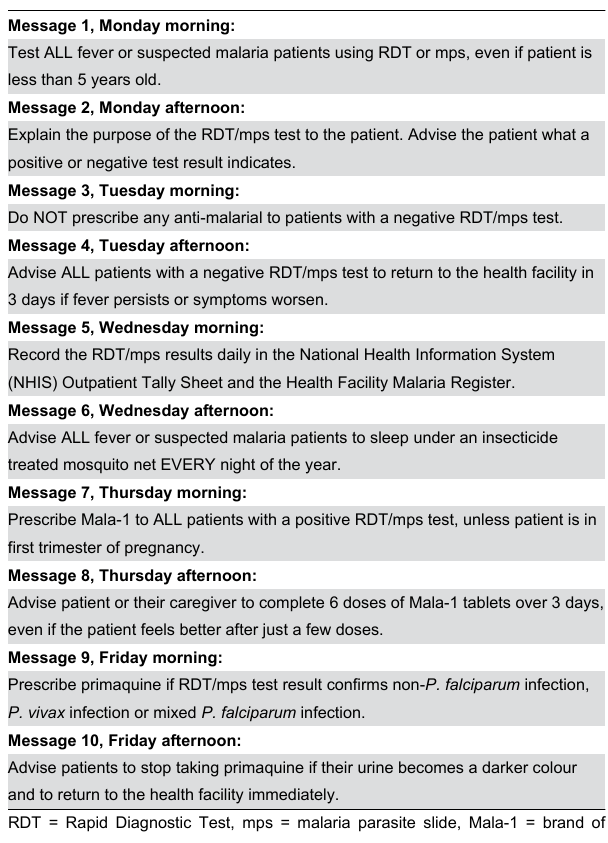
Message 1, Monday morning: Test ALL fever or suspected malaria patients using RDT or mps, even if patient is less than 5 years old. Message 2, Monday